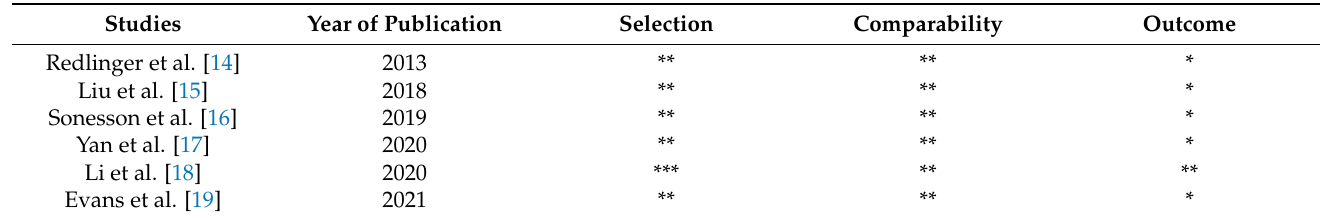
Table 5. Assessment of quality reporting in the gathered literature according to the Newcastle–Ottawa scale